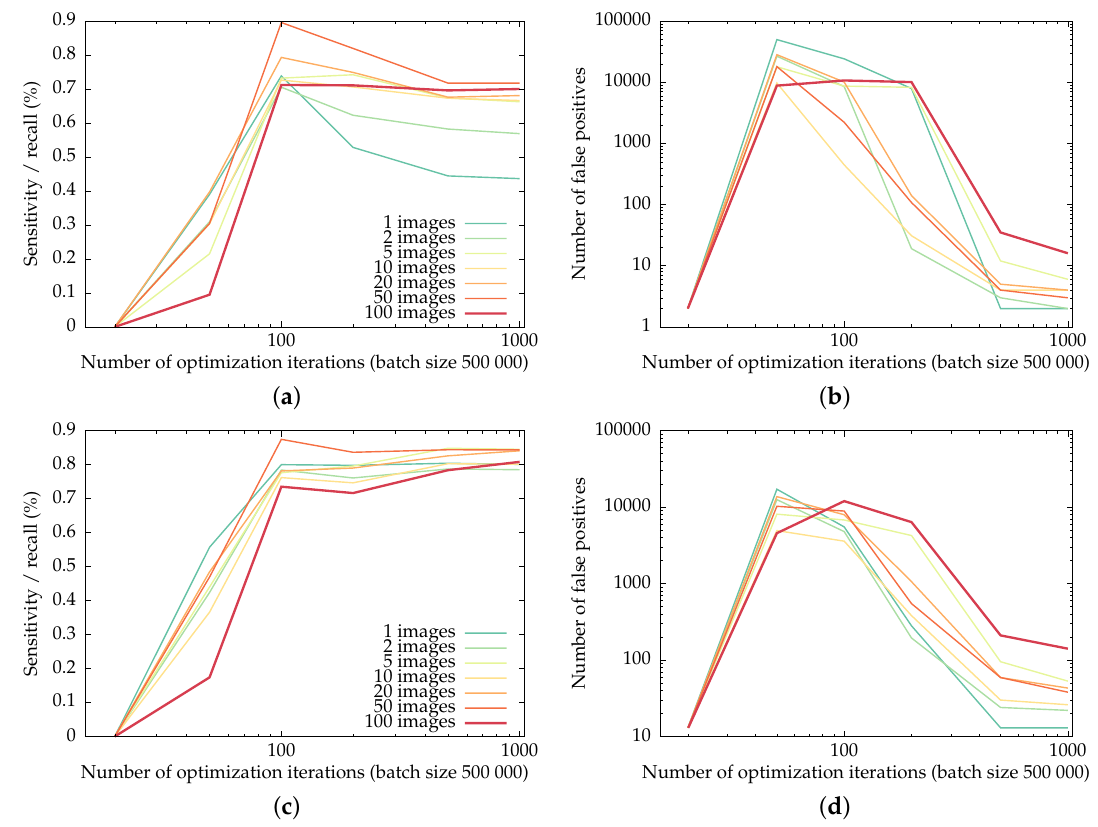
Figure 9. Recall of the checkerboard corners (the fraction of corners detected as such) and the number of false positives in the uEye and GoPro datasets for networks trained on fractions of the training set, as a function of the training iterations. Training was done in batches of 500 000 backpropagations, i.e., an entire image at once. ( a ) and ( b ): recall and false positives for the uEye dataset, ( c ) and ( d ): recall and false positives for the GoPro